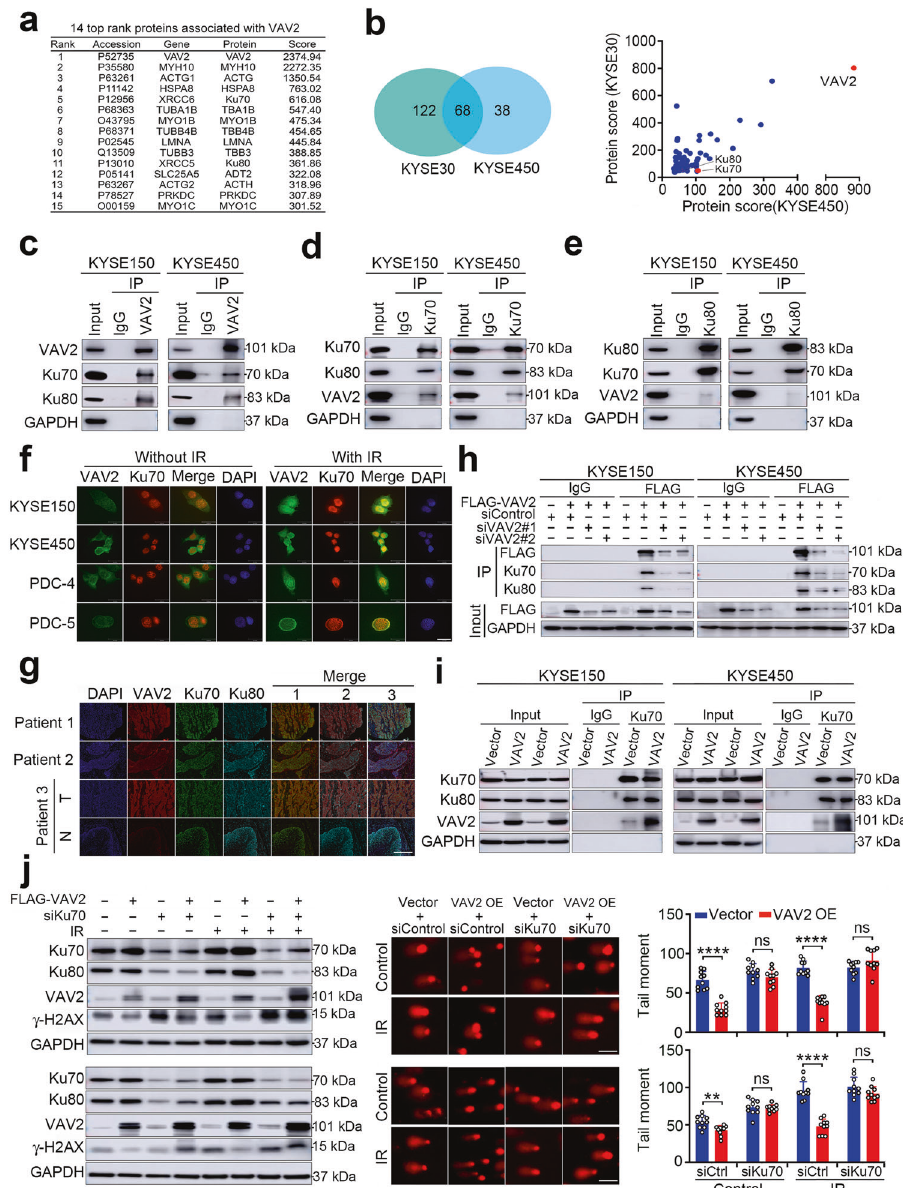
Fig. 4 VAV2 is necessary in Ku70 and Ku80-mediated DNA NHEJ repair. a Fourteen top proteins potentially associate with VAV2 identi fi ed by mass spectrometry in ESCC cells ectopically overexpressing FLAG-tagged VAV2. Cell lysates were immunoprecipitated with antibody against FLAG and antibody against IgG was used as negative control. b Proteins potentially associate with VAV2 in KYSE30 and KYSE450 cells. Left panel is a Venn diagram showing 68 proteins identi fi ed in both cell lines. Right panel shows score of each protein. c – e Western blot detection of VAV2, Ku70 and Ku80 proteins by reciprocal immunoprecipitation with antibody against VAV2 ( c ), Ku70 ( d ) or Ku80 ( e ) in KYSE150 and KYSE450 cells. IgG was used as control. f Immuno fl uorescence analysis of VAV2 and Ku70 co-staining in KYSE150, KYSE450, PDC-4 and PDC-5 cells with or without IR (4 Gy), showing colocalization of VAV2 and Ku70. DAPI was used to label the nucleus. Scale bars, 20 µm. g Multiple immuno fl uorescences analysis of VAV2, Ku70, and Ku80 in clinical ESCC tumor tissues. All tumors (T) show strong colocalization signal of the 3 proteins while the corresponding non-tumor tissues (N) from patient 3, which had low VAV2, show very weak colocalization signal. Merge 1 represents the merge of VAV2 and Ku70, Merge 2 represents the merge of VAV2 and Ku80 and Merge 3 represents the merge of VAV2, Ku70, and Ku80. Scale bars, 100 µm. h Western blot analysis of FLAG-VAV2, Ku70 and Ku80 in ESCC cells ectopically expressing FLAG-tagged VAV2 and treated with siVAV2. Cell lysates were immunoprecipitated with antibody against FLAG or IgG. i Western blot analysis of VAV2, Ku70, and Ku80 in ESCC cells overexpressing VAV2. Cell lysates were immunoprecipitated with antibody against Ku70 or IgG. j Effects of increasing VAV2 expression and decreasing Ku70 expression on DNA damage in ESCC cell lines KYSE150 ( upper panels ) and KYSE450 ( lower panels ). Left panels show Ku70, Ku80, VAV2 and γ -H2AX levels detected by Western blot analysis in cells with different treatment. Middle panels are image of comet assays showing overexpression of VAV2 signi fi cantly diminished DNA damage, which could be reversed by knockdown of Ku70 expression. Right panel are the statistics of tail moments in comet assays. OE, overexpression. Data are mean ± SEM from 3 replicate experiments and 10 fi elds were randomly selected for each experiment. ** P < 0.01; **** P < 0.0001 and ns, not signi fi cant of Student ’ s t -test